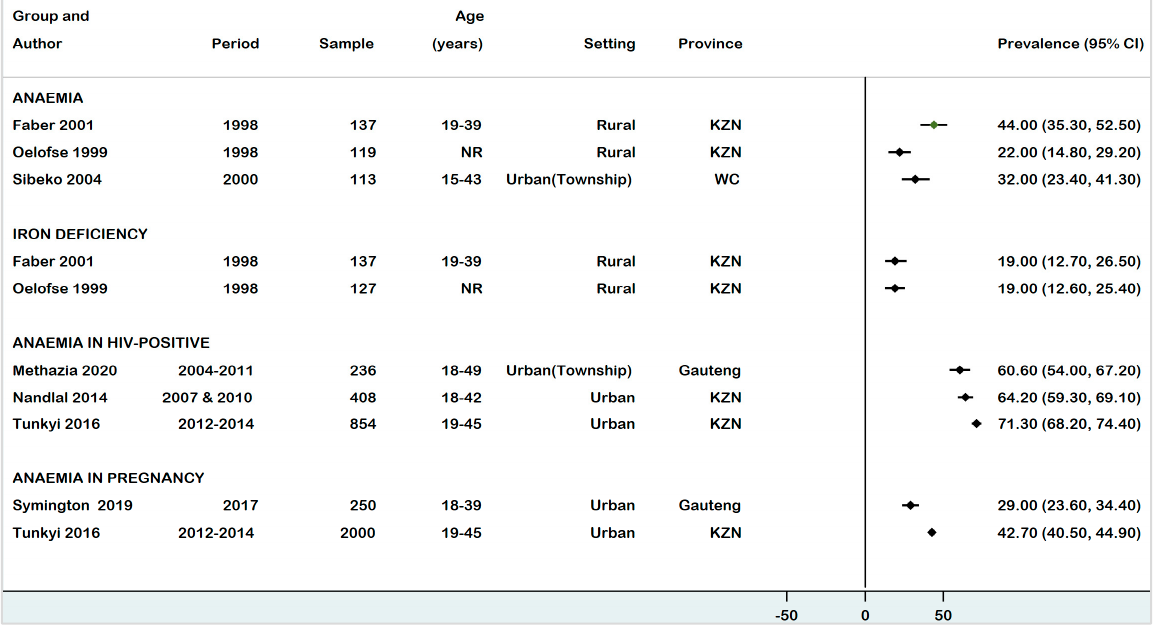
Figure 2. Forest plot of prevalence of anaemia and ID among WRA in South Africa (15 − 49 years), 1997–2021.